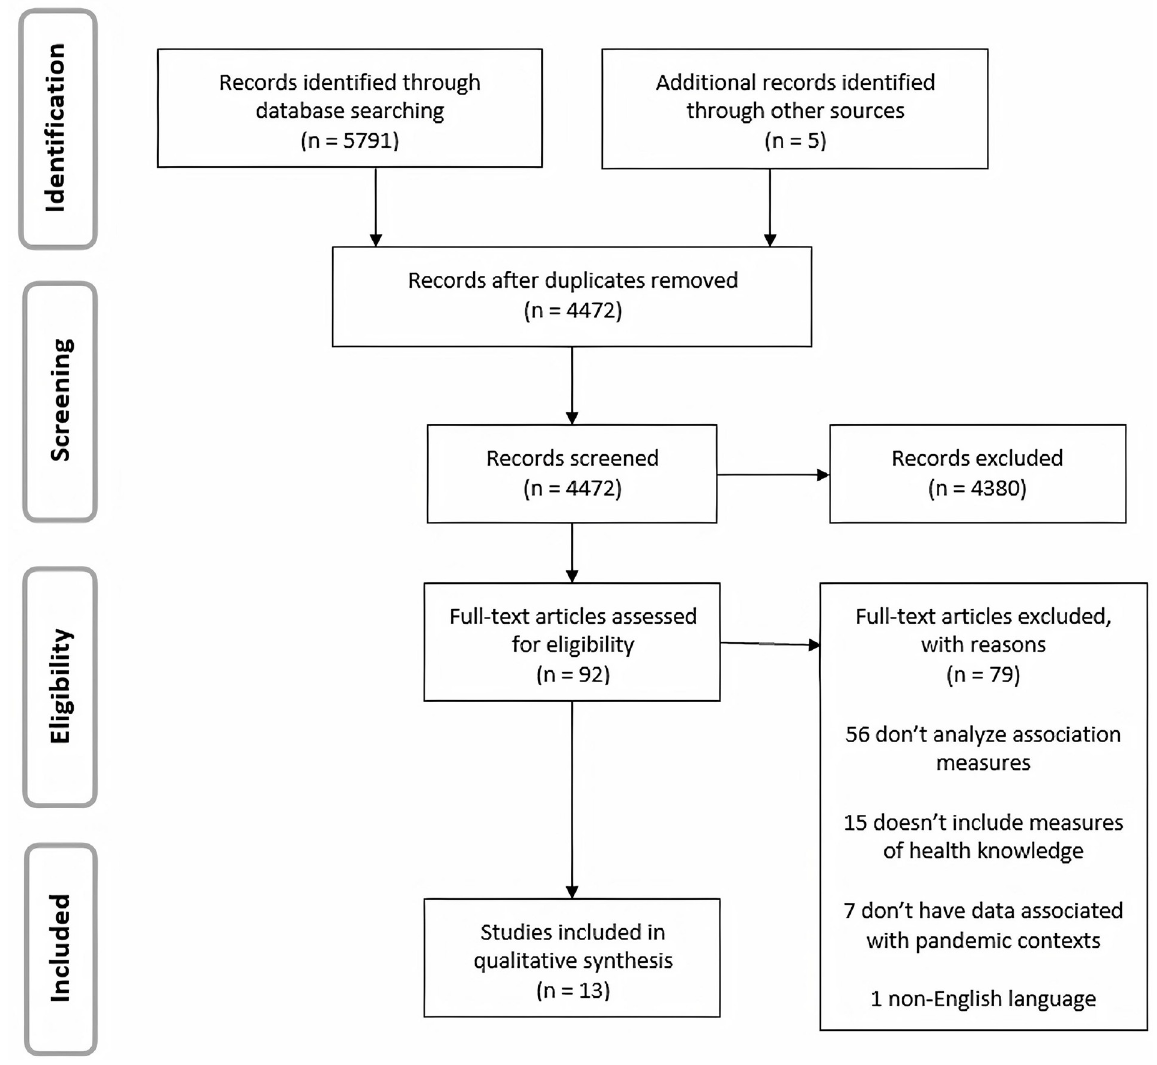
Fig 1. PRISMA flow diagram of the study selection